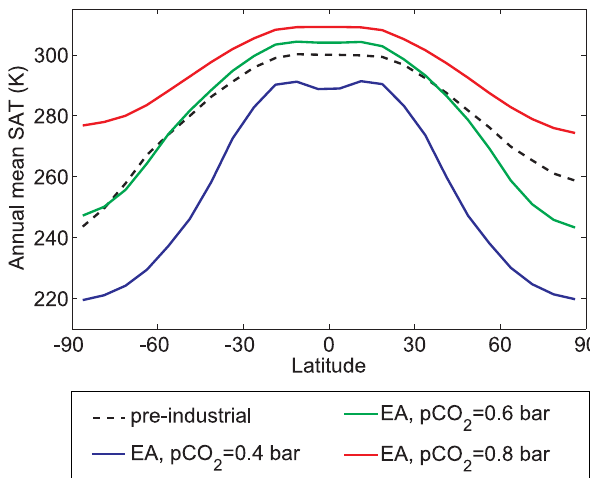
Fig. 6. Annual and zonal mean SAT for the following states: pre-industrial (black), the critical state of the early Archean ( p CO 2 =0.4bar, blue), the state of the early Archean with present- day mean SAT of 288K ( p CO 2 =0.6bar, green) and an ice-free state ( p CO 2 =0.8bar,